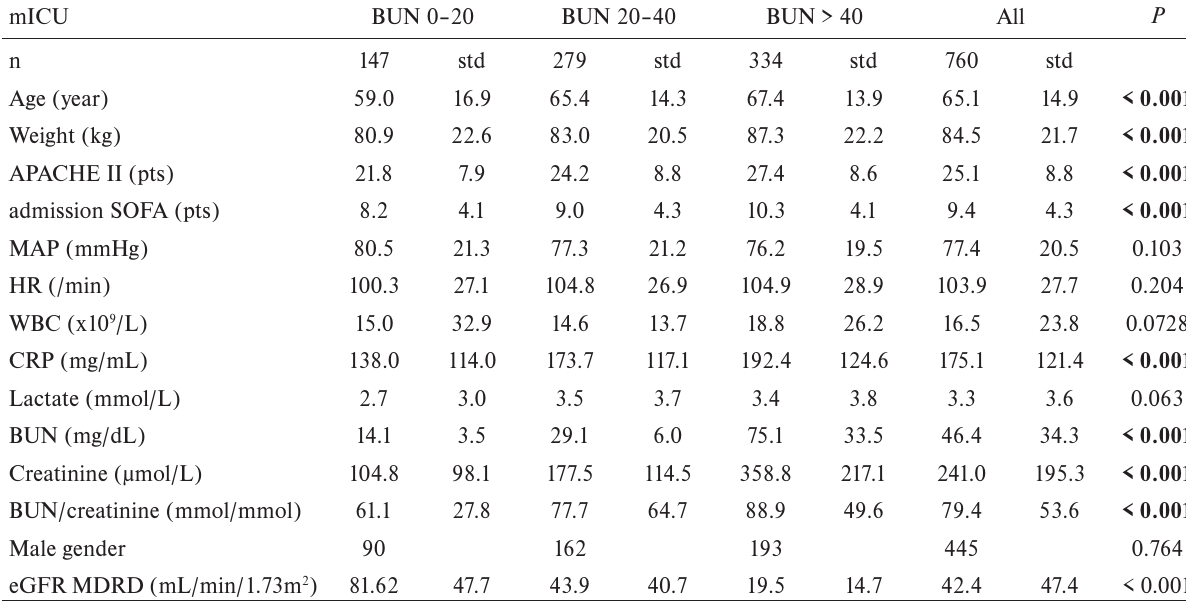
Table 2. Demographics of Czech